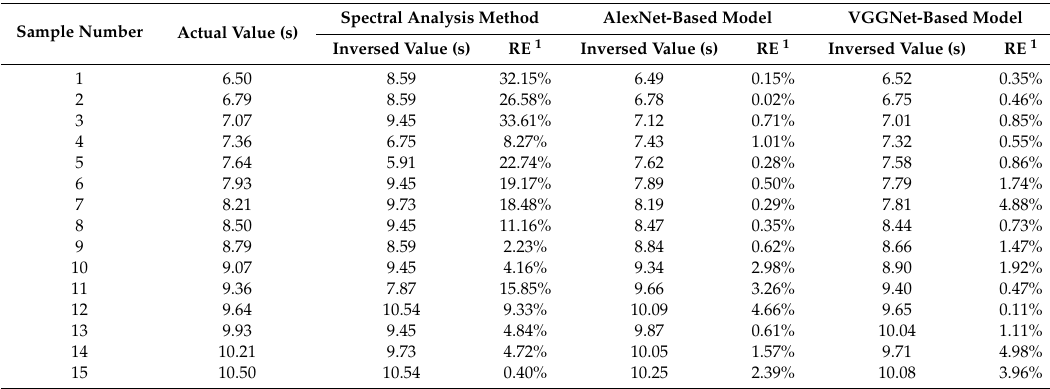
Table 2. Inversion results of the wave’s spectral peak period ( T S ).